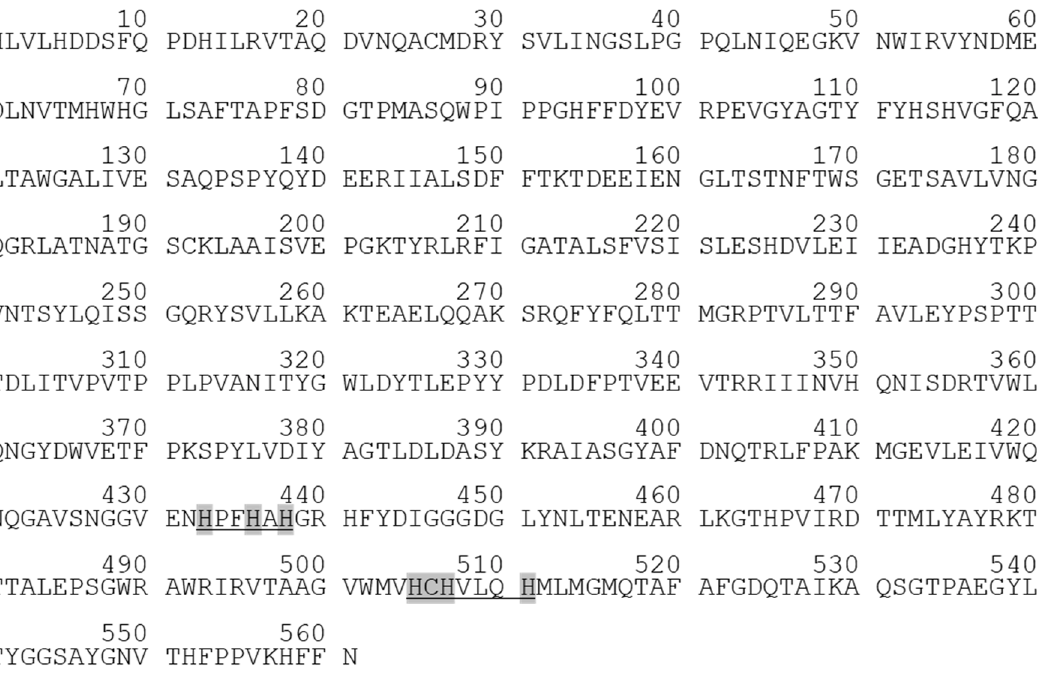
Figure 1. Sequence of Af _AO1: conserved regions are underlined, and copper-coordinating residues marked in grey. The sequence is displayed, as it was expressed without signal peptide.